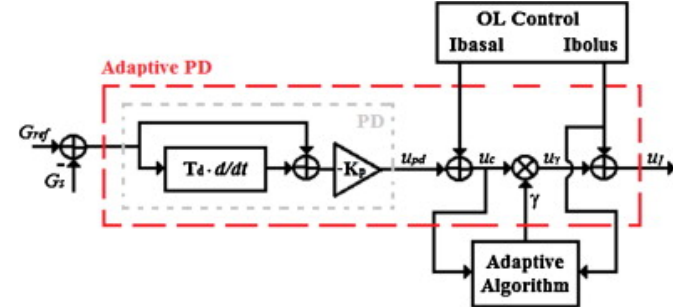
Figure 6. Regular proportional-derivative control algorithm diagram for flow-based position control of the robotic bilateral [66] (Copyright 2013, Elsevier).